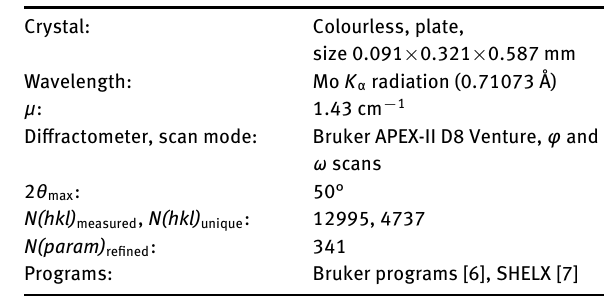
Table 1: Data collection and handling.